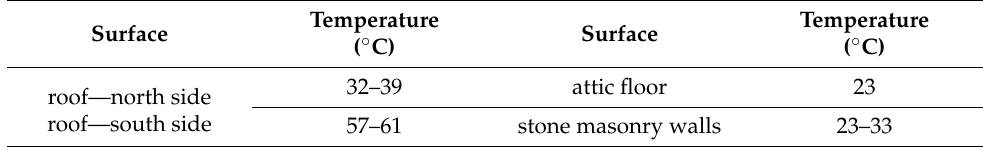
Table 4. Surface temperatures at 12:00 a.m. obtained from BPS simulation.